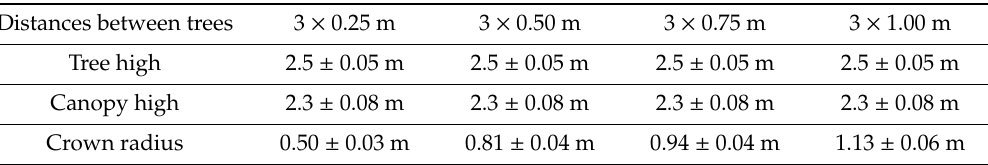
Table 1. Apple tree height and crown (super spindle) radius depending on planting density. The mean value (n = 15) ± standard deviation is presented.